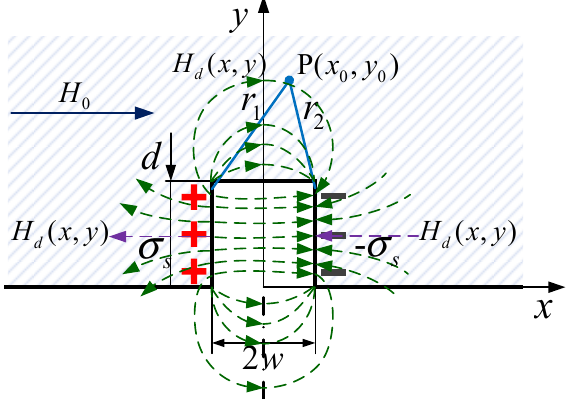
Figure 2. Magnetic field distribution based on the magnetic charges model. It can be seen from Equation (2) that H x ( x , y ) is an even function and H x ( x , y ) de- creases with an increase in | x | . The discontinuity orientation is perpendicular to the magnetization direction (the x direction), and the internal magnetic field of the material is primarily along x . In this case, the change in the x component is consistent with H sum ( x , y ) . Therefore, we primarily analyze the x component of the magnetic field and use H d ( x , y ) to represent H x ( x , y ) in Figure 2. The magnetic field in the material consists of not only the H d ( x , y ) caused by the magnetic charges presented in Figure 2 but also the original magnetic field without the slot H b ( x , y ) . When there is no slot in the material, the magnetic field lines are in the same direction as the incident field lines outside the material. Thus, the magnetic flux travels directly through the interior of the material without any perturbation, as shown in Figure 3a,b, which were obtained by FEA. The magnetic field is distributed evenly throughout the material without any magnetic field perturbation, as indicated in Figure 3c.